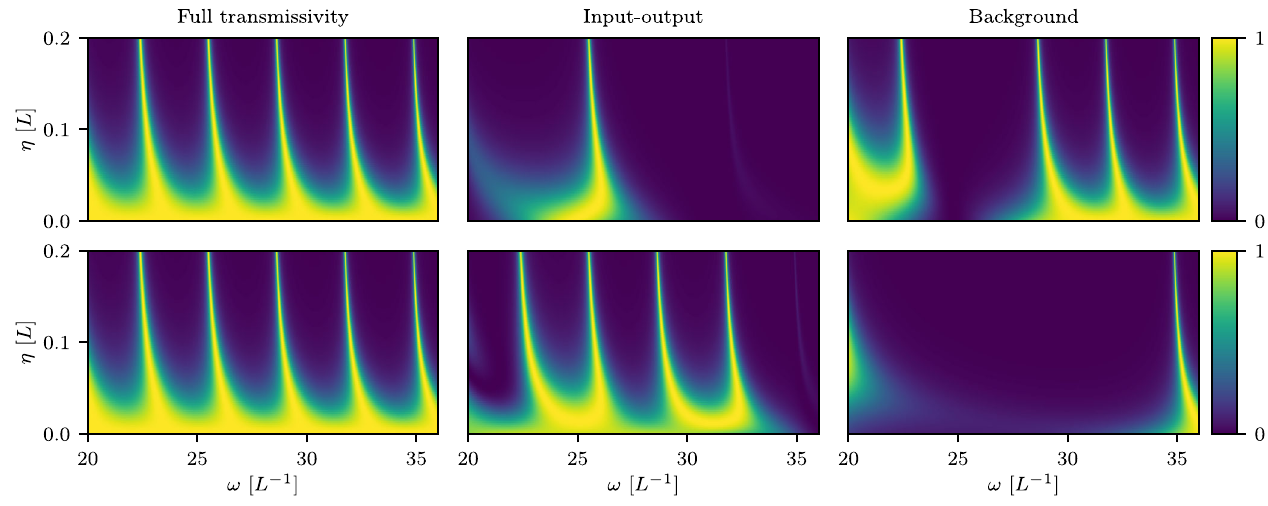
FIG. 5. Transmission spectra for a Fabry-Perot cavity as a function of the mirror quality η . The top row shows the case in which the system comprises the single mode λ ¼ 8 . The bottom row shows corresponding results with the system consisting of the modes λ ∈ f 7 ; 8 ; 9 ; 10 g . In both cases, the left column illustrates the full transmissivity of the system. The middle and right columns show the input-output ( S ) and the background ( S ) contributions, respectively. The full result can be obtained either from standard methods io bg such as a transfer matrix formalism also known as Parratt ’ s formalism [102,103] or as a product of the input-output and background scattering